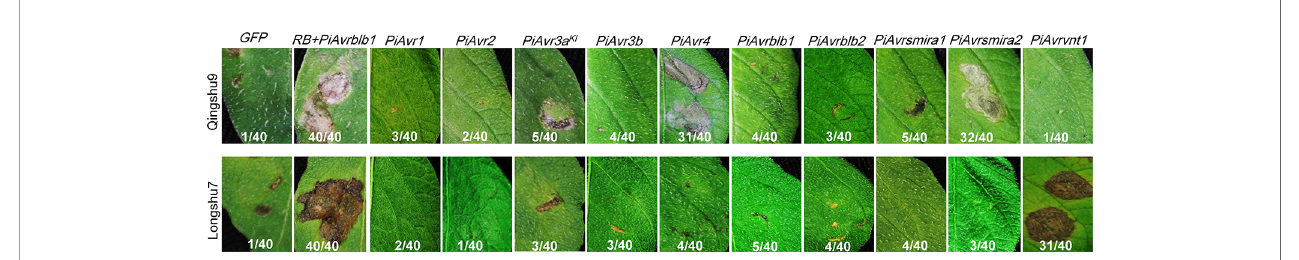
FIGURE 3 | Speci fi c HR induced by 10 known P. infestans Avr genes in two potato varieties, Qingshu9 and Longshu7. In Qingshu9, the typical HR was induced by PiAvr4 and PiAvrsmira2 , whereas Longshu7 was responsive to PiAvrvnt1.1. A. tumefaciens AGL1 suspension with an OD 600 value of 0.4 was used for in fi ltration of 4- week-old potato leaves. GFP was used as the negative control, shown at the left side, while the positive control was indicated by co-in fi ltration of agrobacteria carrying PiAvrblb1 and RB , respectively. The indicated are the number of HR-responsive leaves/total number of the in fi ltrated leaves. All pictures were taken at 5 –